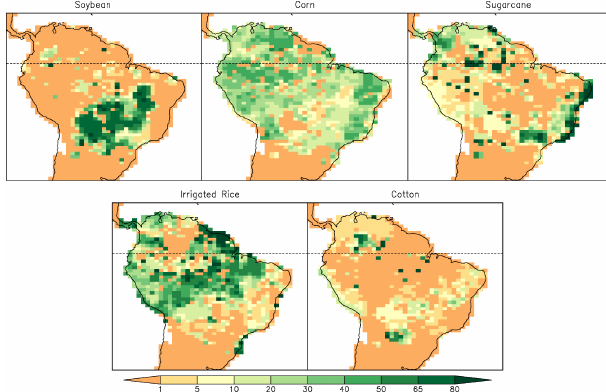
Figure 2. Distribution of each tropical crop as replacement vege- tation in the Amazon region, with the color bar indicating the per- centage of each grid box.